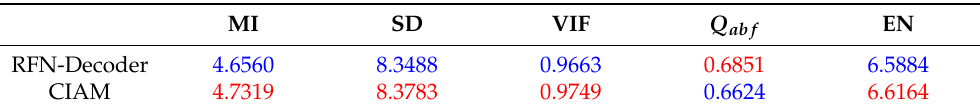
Table 8. The results of ablation study for the CSFI on the 361 MSRS dataset. The red value indicates the best result and the blue value indicates the second best result. The RFN-decoder indicates the decoder of the RFN-Nest.